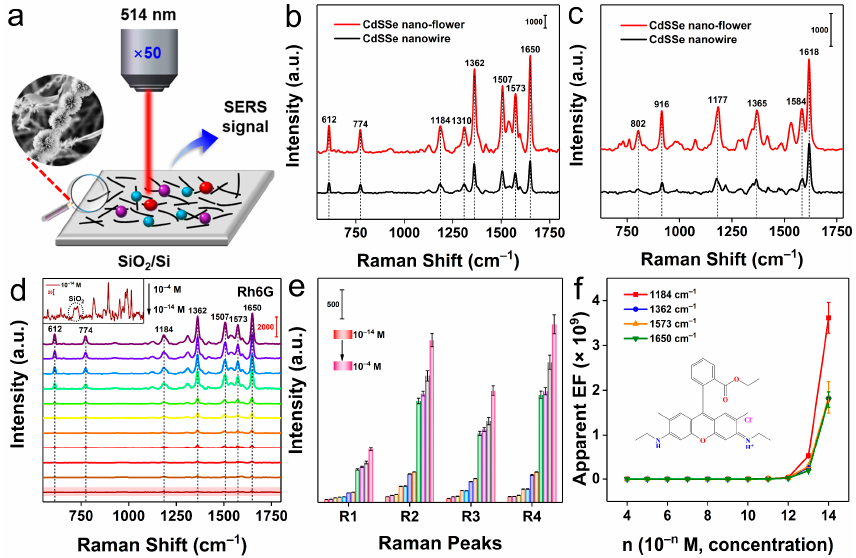
Figure 2. ( a ) Schematic illustration of CdSSe NFs-based substrate SERS experiments. ( b , c ) Comparison of the SERS performance of CdSSe NWs and CdSSe NFs substrates for Rh6G and MB probes, respectively. ( d ) SERS spectra of Rh6G solutions at different concentrations (inset shows the SERS spectrum of Rh6G at 10 − 14 M concentration). ( e ) The trend of concentration-dependent Raman peak intensity (R 1 to R 4 : 1184, 1362, 1573, and 1650 cm − 1 ). ( f ) Apparent EF-concentration function in CdSSe NFs-Rh6G SERS systems.